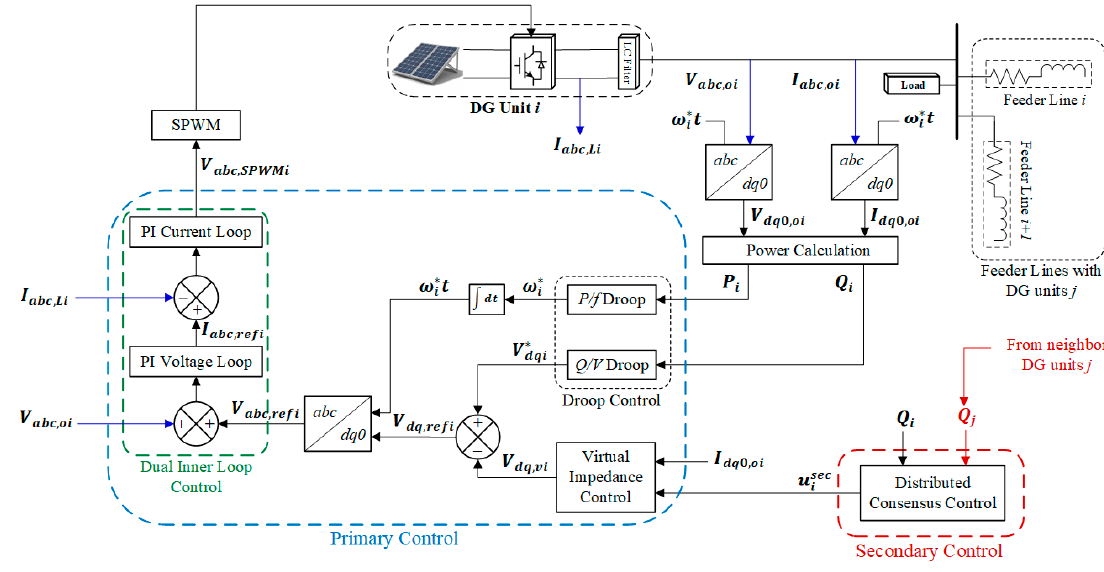
Figure 6. The scheme of the proposed control.